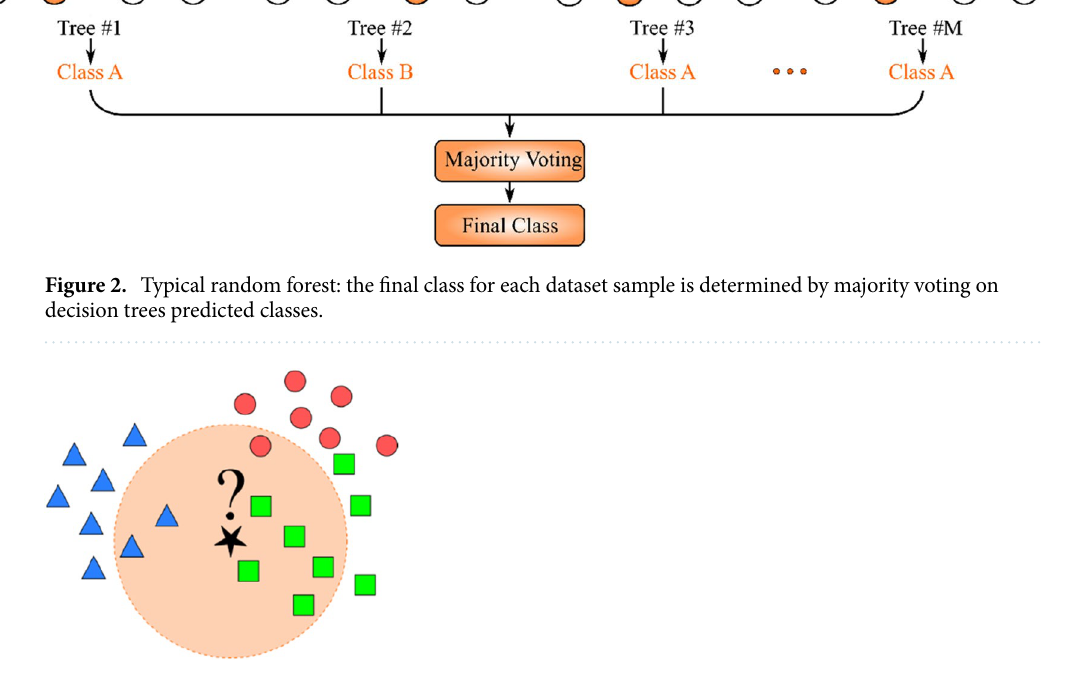
Figure 3. Illustration of KNN (K = 8) classification for test sample (denoted as ?): triangles, squares, and circles represent samples from a 3-class training